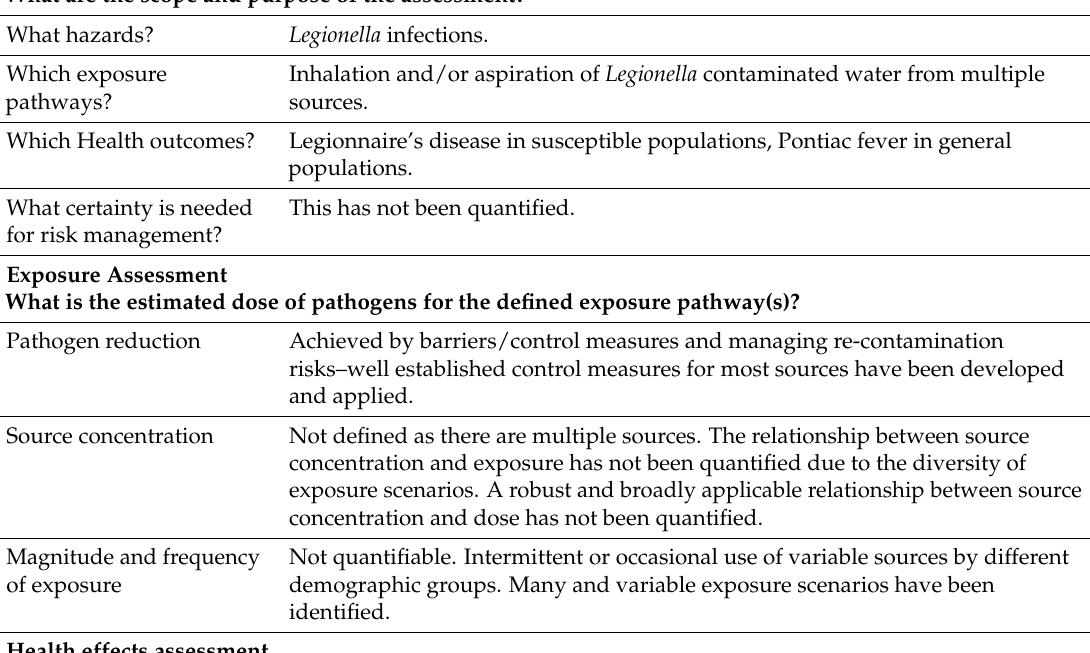
Table 1. Summary of the uncertainties associated with Legionella Quantitative Microbial Risk Assessment